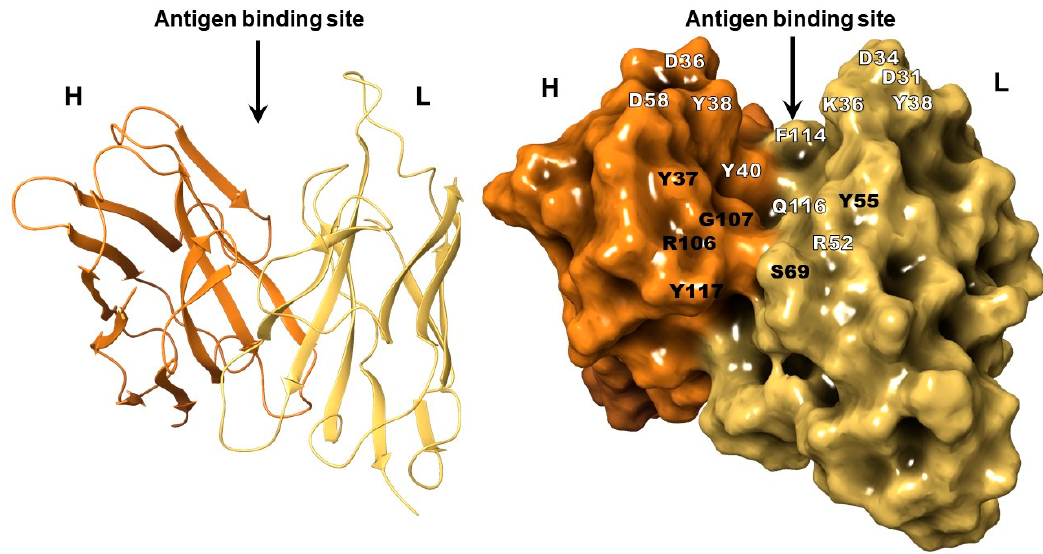
Figure 4. 3D model of the VH and VL complex of the 10H10 antibody: amino acids reactive with FL region of E protein are marked white color (hereinafter, H and L are name of chain).